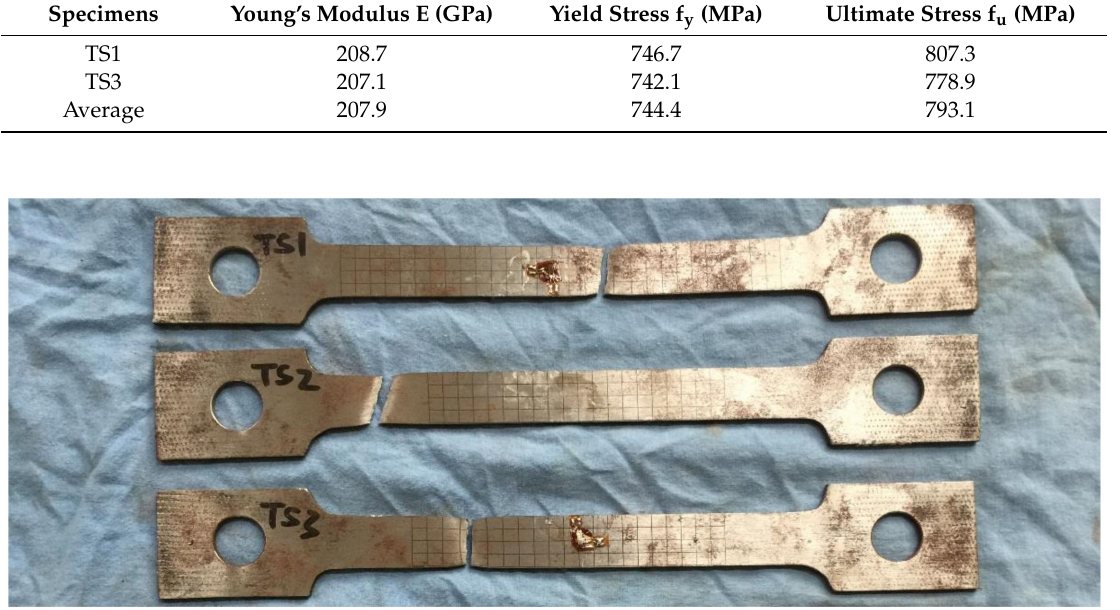
Figure 1. Specimens of tensile testing after